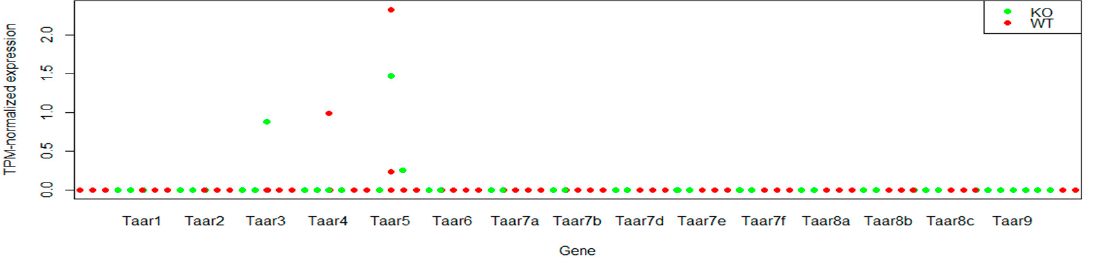
Figure 3. Expression levels of TAARs in mouse hippocampal CA1 pyramidal neurons (GSE94559). KO—Frm1 knockout mice; WT—wild-type control group.